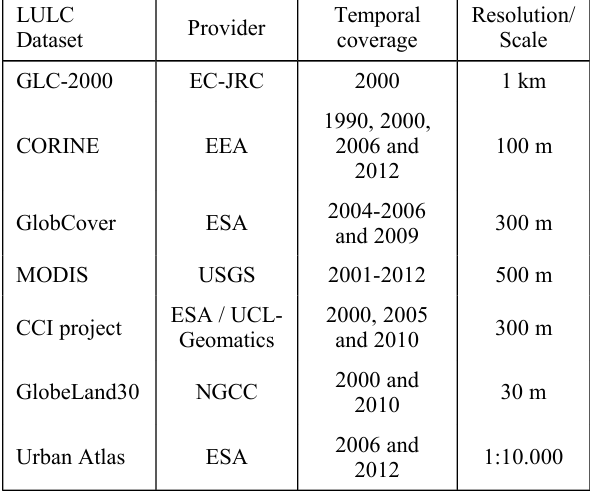
Table 1. LULC datasets of Europe at continental